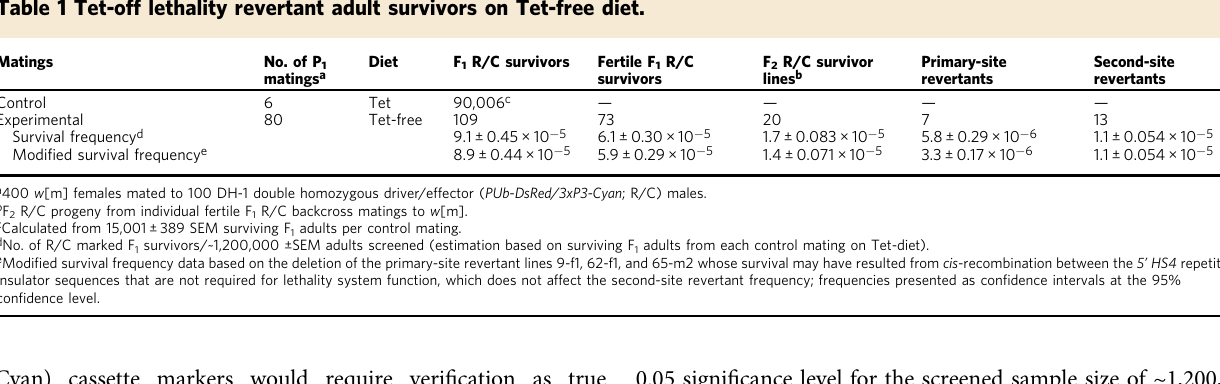
(Cyan) cassette markers would require veri fi cation as true heritable lethal revertants from a backcross to w [m] that yields double-marked Red/Cyan F 2 surviving progeny on Tet-free diet (Fig. 1b).